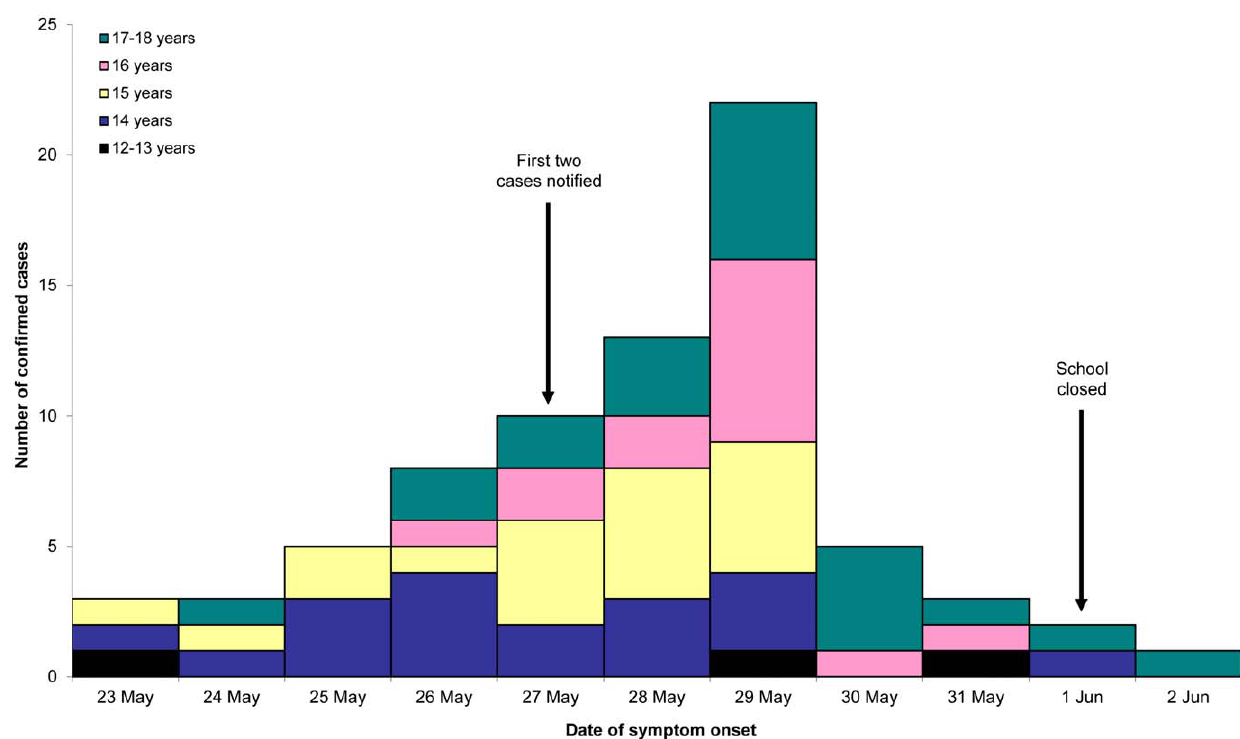
Figure 3. Confirmed influenza A(H1N1)pdm09 cases at School A by date of onset and age group, Victoria, 2009.